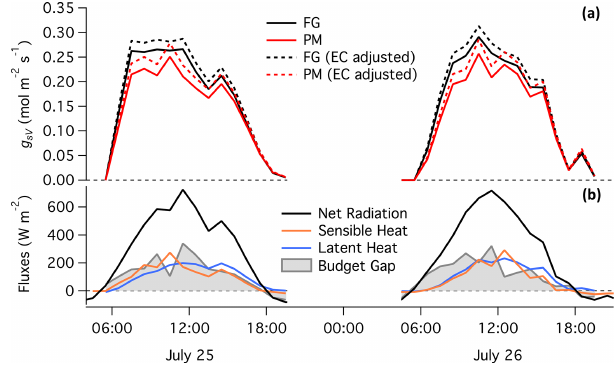
Figure 6. (a) Hourly canopy stomatal conductance to water vapor calculated at Howland Forest (Hollinger, 1996) over 2d in 2014 by the same approaches as in Fig. 3. (b) Measured energy fluxes and budget